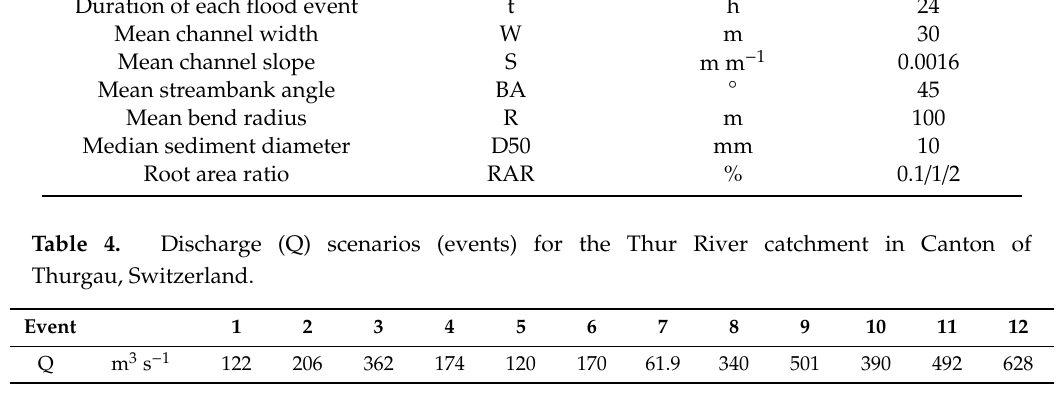
The e ff ects of roots for di ff erent discharge scenarios were also modeled for the Thur River. Based on flood statistics, discharge scenarios for return periods (RP) of 2 years ( HQ 2 = 576 m 3 s